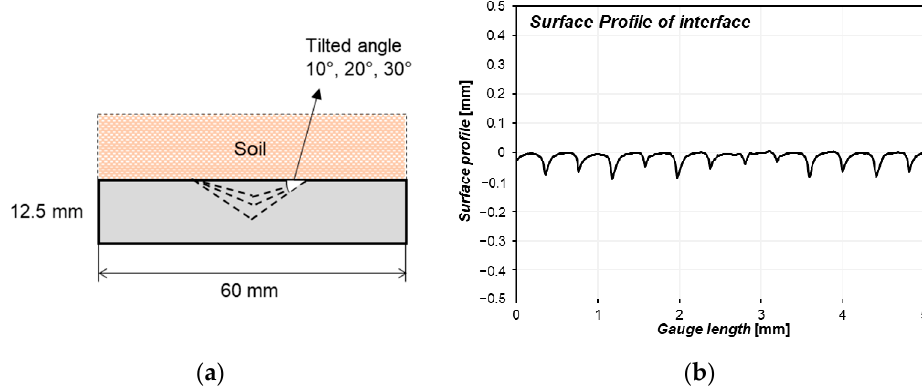
Figure 3. Structural materials: ( a ) schematic diagram; ( b ) typical surface profiles.